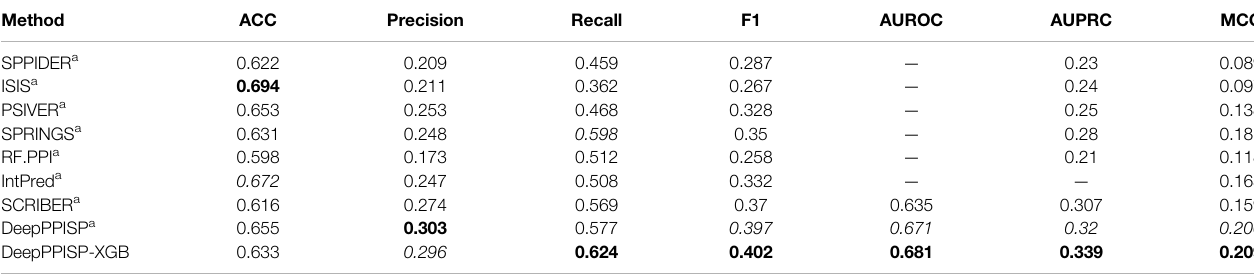
TABLE 1 | Comparison with other state-of-the-art methods.